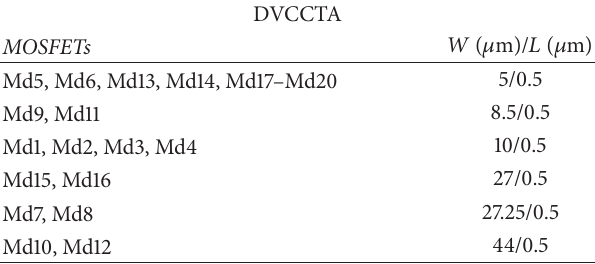
Table 2: Aspect ratio of transistors.